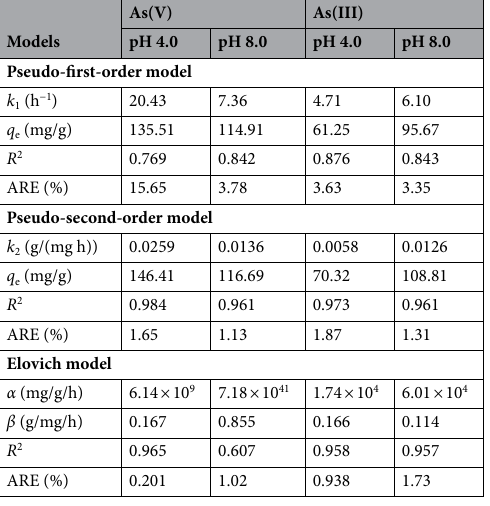
Table 2. Adsorption kinetics parameters for As(V) and As(III) adsorption on iron hydroxide nanopetalines at pH 4.0 and